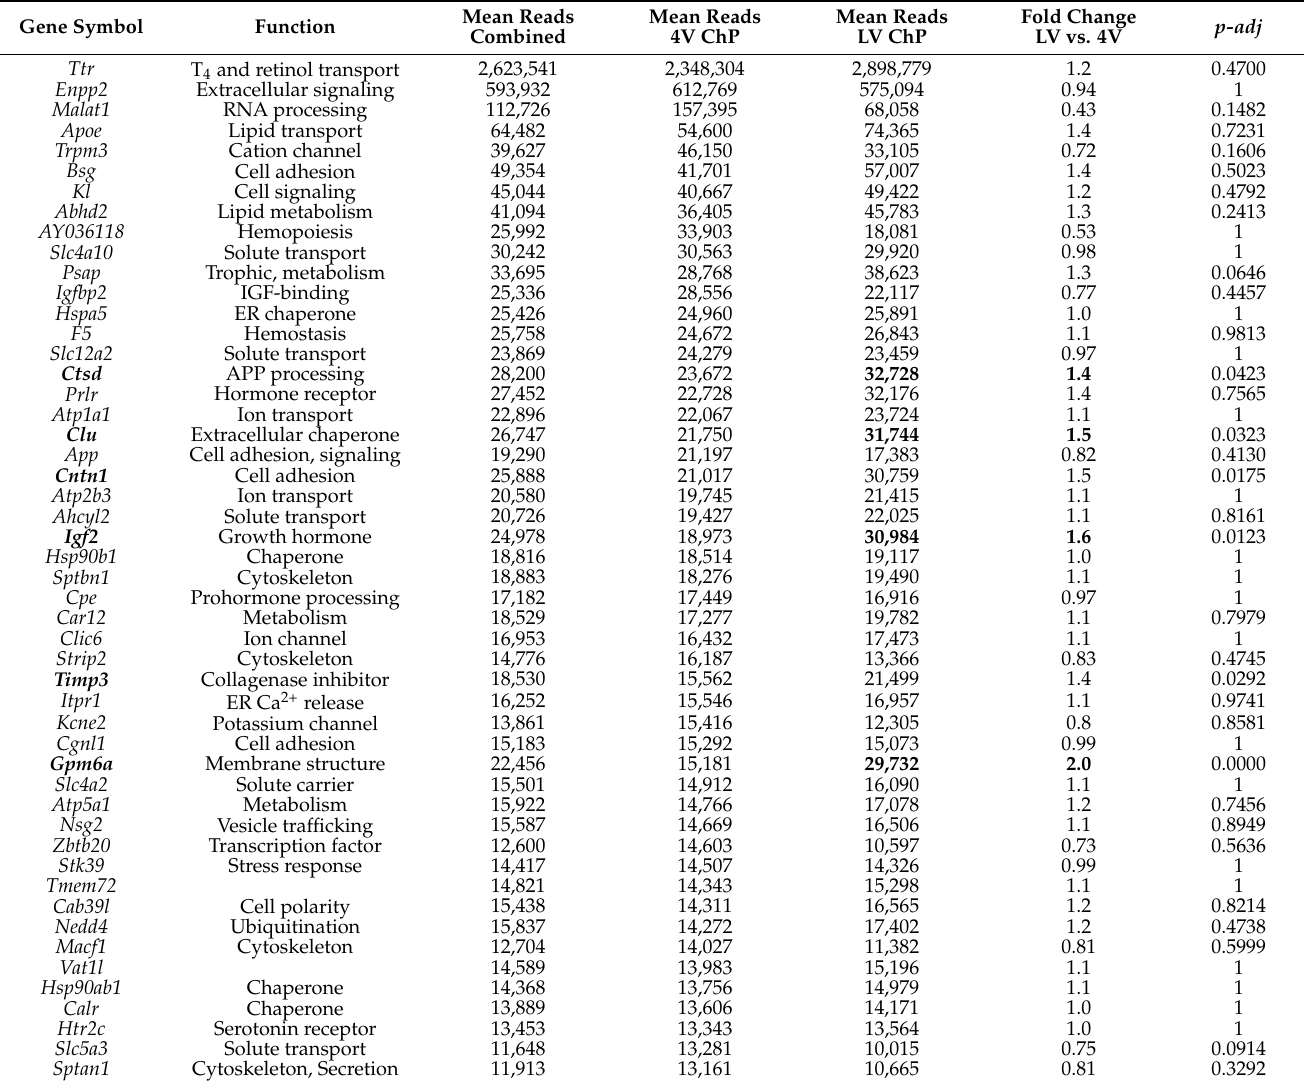
Table 1. Top 50 genes expressed in lateral ventricle (LV) and fourth ventricle (4V) choroid plexus (ChP). Significantly different expression between structures is indicated in